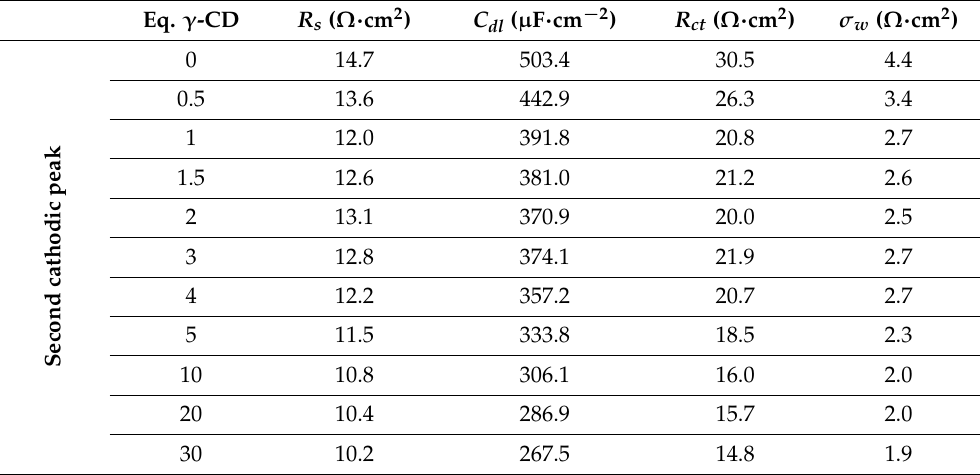
Table 2. Electrochemical parameters obtained from the best fit of impedance data for POM and POM–CD reduction reaction at the second cathodic peak ( − 0.43 V vs. Ag/AgCl). Data obtained from EIS fitting using ZView software is shown in Table